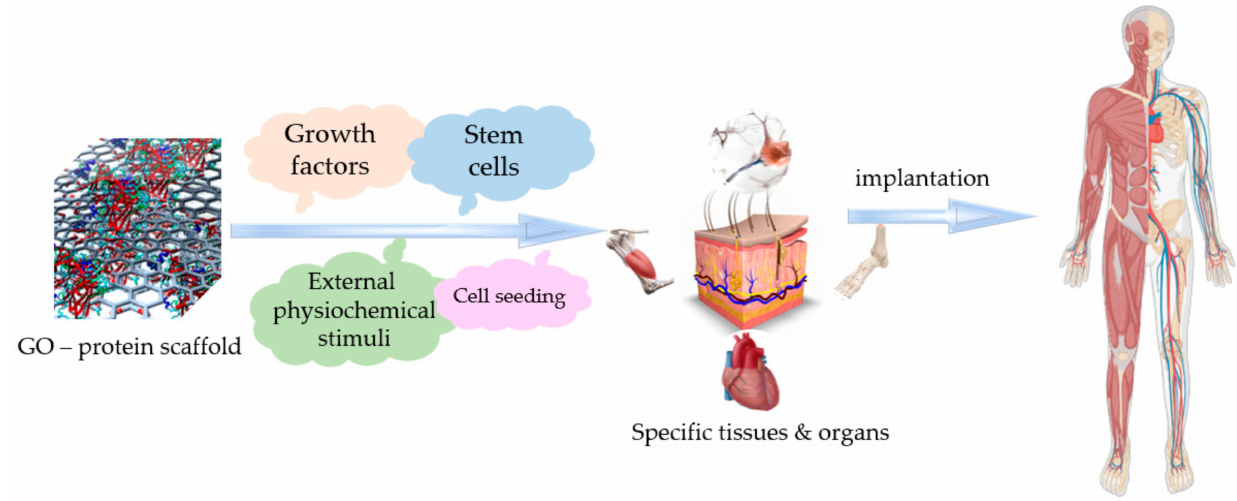
Figure 4. Applications of graphene oxide–protein-based scaffolds in tissue